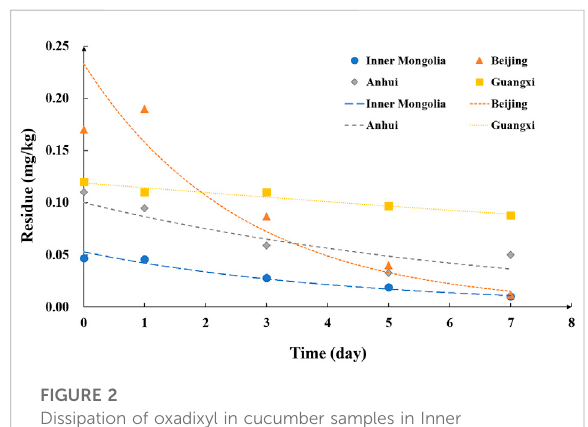
FIGURE 2 Dissipation of oxadixyl in cucumber samples in Inner Mongolia, Beijing, Anhui, and